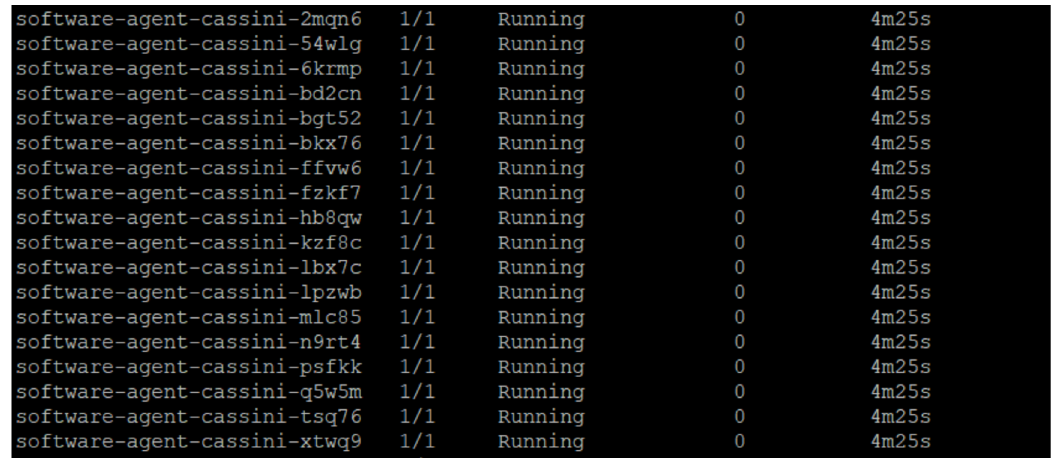
Figure 6. Screenshot of the CLI of Kubernetes showing 18 running agent containers.